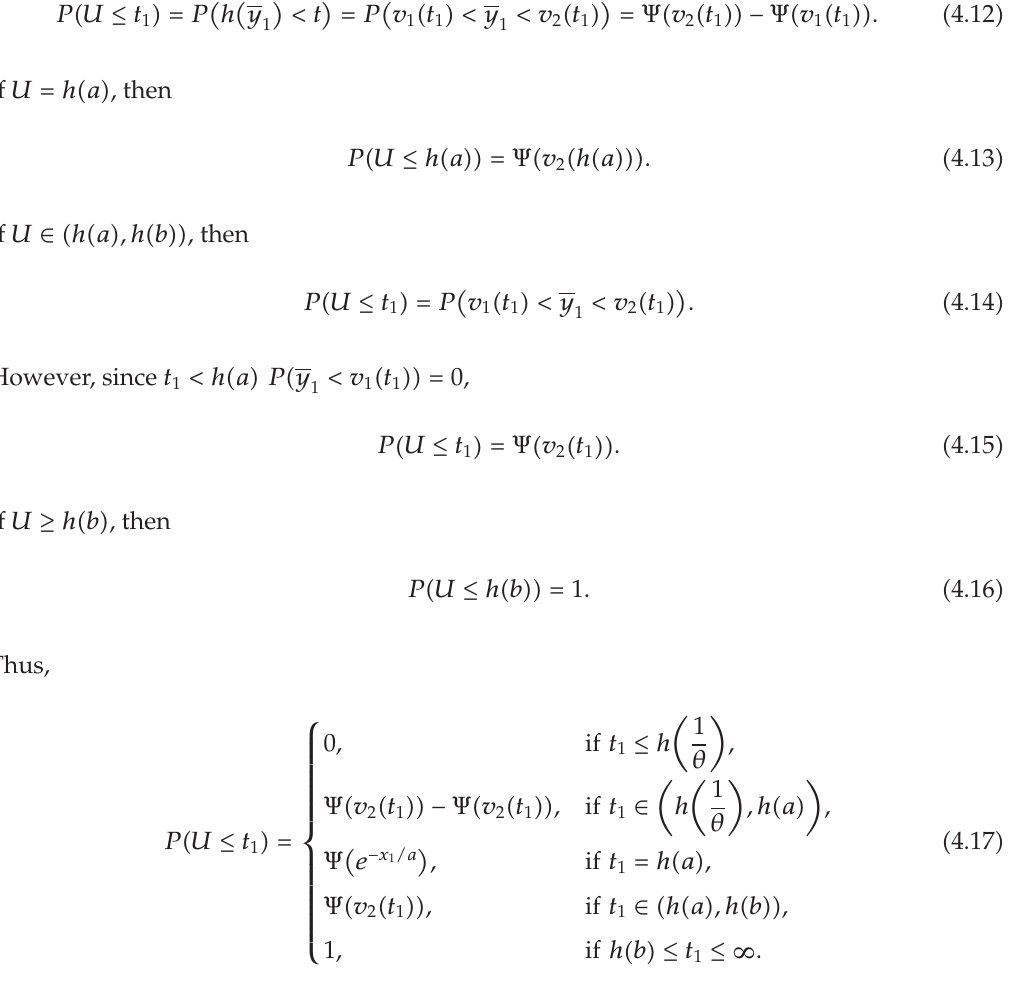
for θ (cid:6) 1, a (cid:6) . 25, and b (cid:6) 1